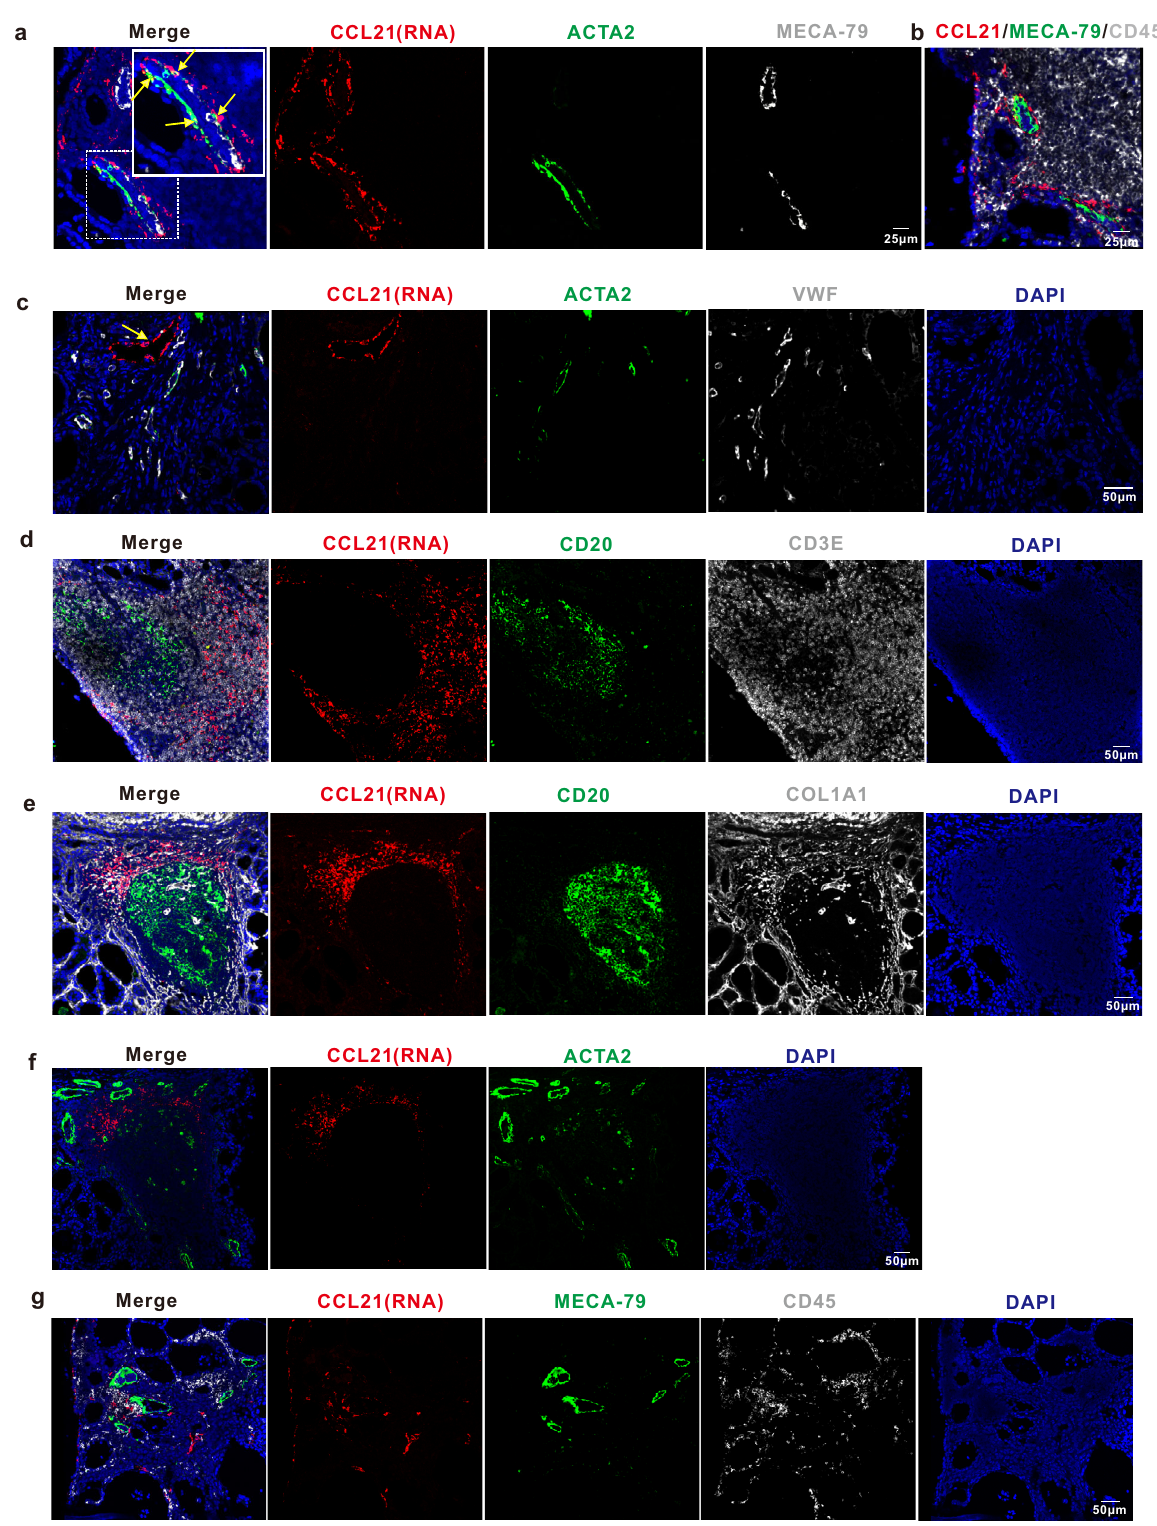
Fig. 5 Distribution of CCL21 + stromal cells in thyroid tissues of HT patients suggests the critical role of CCL21 + fi broblasts in tertiary lymphoid organ organization. a RNAscope in situ hybridization combined with polychromatic immuno fl uorescence staining showing the distribution of ACTA2 + CCL21 + myo fi broblasts in the adventitia of HEVs. The colocalization of CCL21 and ACTA2 (yellow arrows) indicate CCL21 + myo fi broblasts in the adventitia of MECA-79 + HEVs. b Adjacent slice of a shows MECA-79 + HEVs are surrounded by many lymphocytes. c The distribution of CCL21 + lymphatic vessels endothelial cells. CCL21 signal shows a lumen structure negative of VWF and ACTA2. d – f Large numbers of CCL21 + fi broblasts are distributed in the T cell zone of the TLOs. CD20 indicates B cells and CD3E indicates T cells. Section in f is the adjacent slice of ( e ). CCL21 + cells are positive for COL1A1 but negative for ACTA2. g In areas with less lymphocytic in fi ltration, all CCL21 + fi broblasts are around lymphocytes.